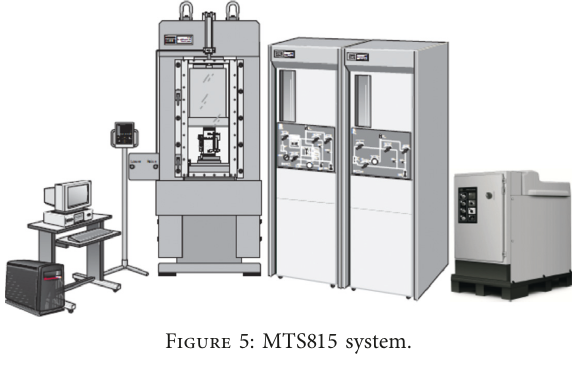
Figure 5: MTS815 system.